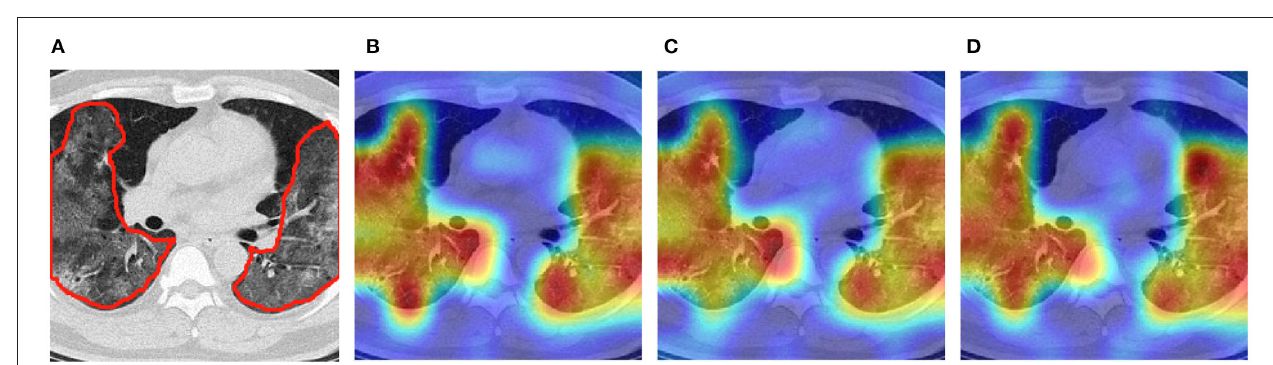
FIGURE 17 | Heatmaps of our PSCNN model. (A) Manuel delineation. (B) Heatmap (Run 1). (C) Heatmap (Run 2). (D) Heatmap (Run 3).